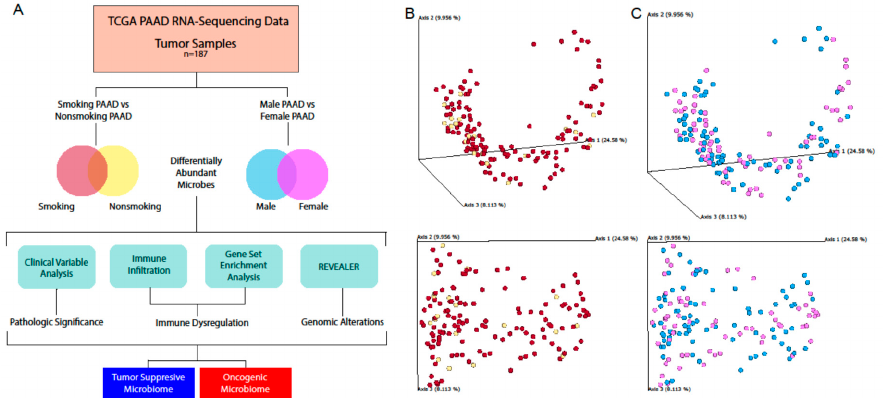
Figure 4. Schematic of etiological analyses. ( A ) A graphical schematic of the analyses used to characterize and investigate the e ff ects of etiology-specific microbiota. The Qiime2 framework was used to calculate the beta diversity and visualize di ff erences between ( B ) smokers and nonsmokers and ( C ) males and females via principle component